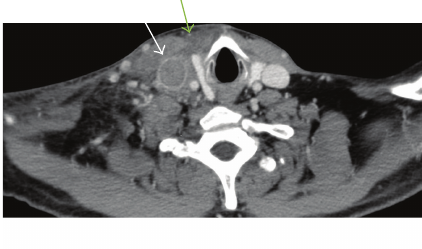
Figure 2: Thrombosis of the right internal jugular vein is noted (white arrow). There is hyperemia of the vein wall, and the vein is dilated to 2.9 × 2.4 cm. There is extension of the thrombus into the subclavian vein. There is extension of thrombus into the innominate vein as well. There is a mediastinal soft tissue density measuring 4.1×2.8 cm (green arrow). The right vertebral artery is diminutive in size. The basilar artery is patent and the vertebral arteries are patent. The left internal jugular vein is patent. The origins of great vessels are patent. The thrombus in the right jugular vein extends up to the level of the skull base. The extension of the thrombus into the sigmoid sinus on the right is to be noted. The dilated jugular vein is exerting mass effect on the adjacent thyroid gland.